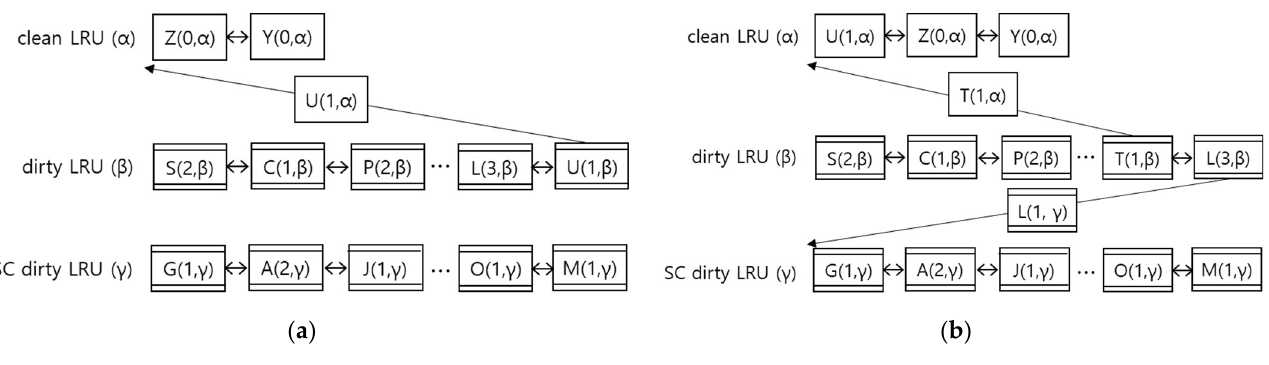
Figure 2. Operations of the early flush. ( a ) A case of an immediate early flush; ( b ) a case given a second chance.